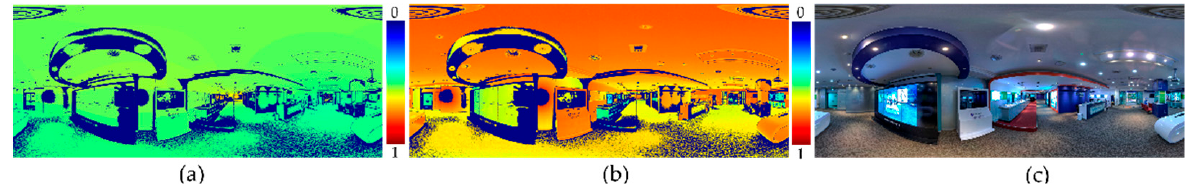
Figure 6. Examples of reflective range images and depth range images. ( a ) is the depth range image, ( b ) is the reflection range image, and ( c ) is the RGB image.